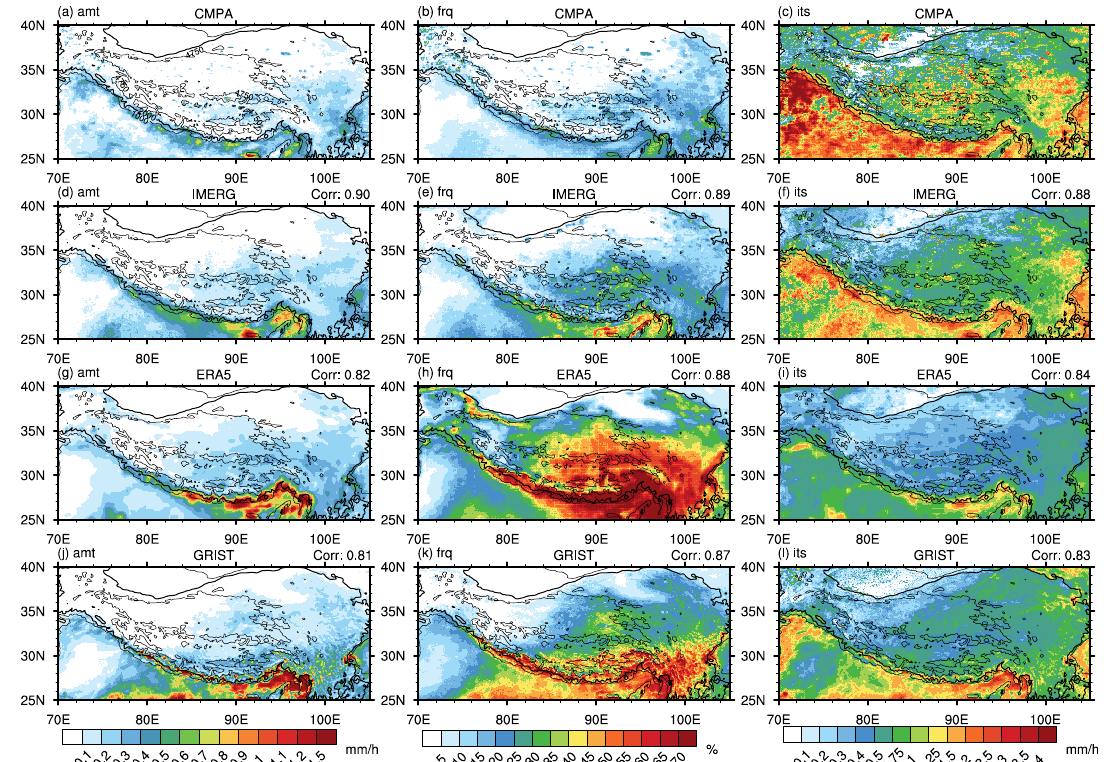
Figure 2. Precipitation spatial pattern (left: amount (mm/h), middle: frequency (%), right: intensity (mm/h)) derived from CMPA ( a – c ), GPM ( d – f ), ERA5 ( g – i ), and GRIST ( j – l ). The superscript numbers in the rightmost trio of columns are the pattern correlations between CMPA and the other three datasets separately. The thick black contour depicts terrain heights of 2000 m, and the thin black contours represent 1000 and 4750